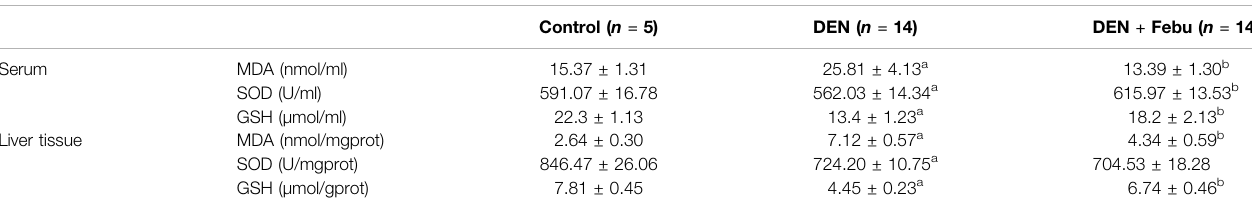
TABLE 2 | MDA, SOD, and GSH activity in serum and liver of rats (mean ± S.E.M).